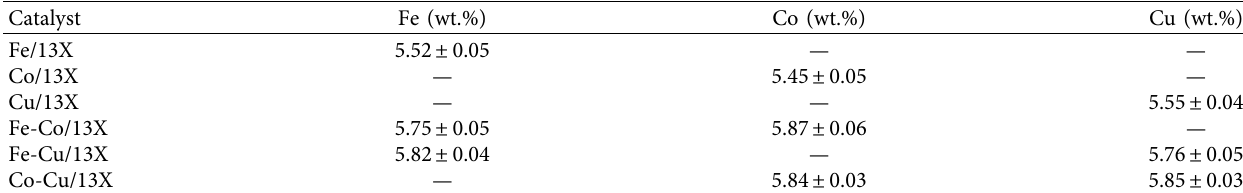
Figure 4: TG curve of rapeseed residual biomass (a) and DTG curve of rapeseed residual biomass Table 2: Metal content in different metal/13X zeolite catalyst samples.